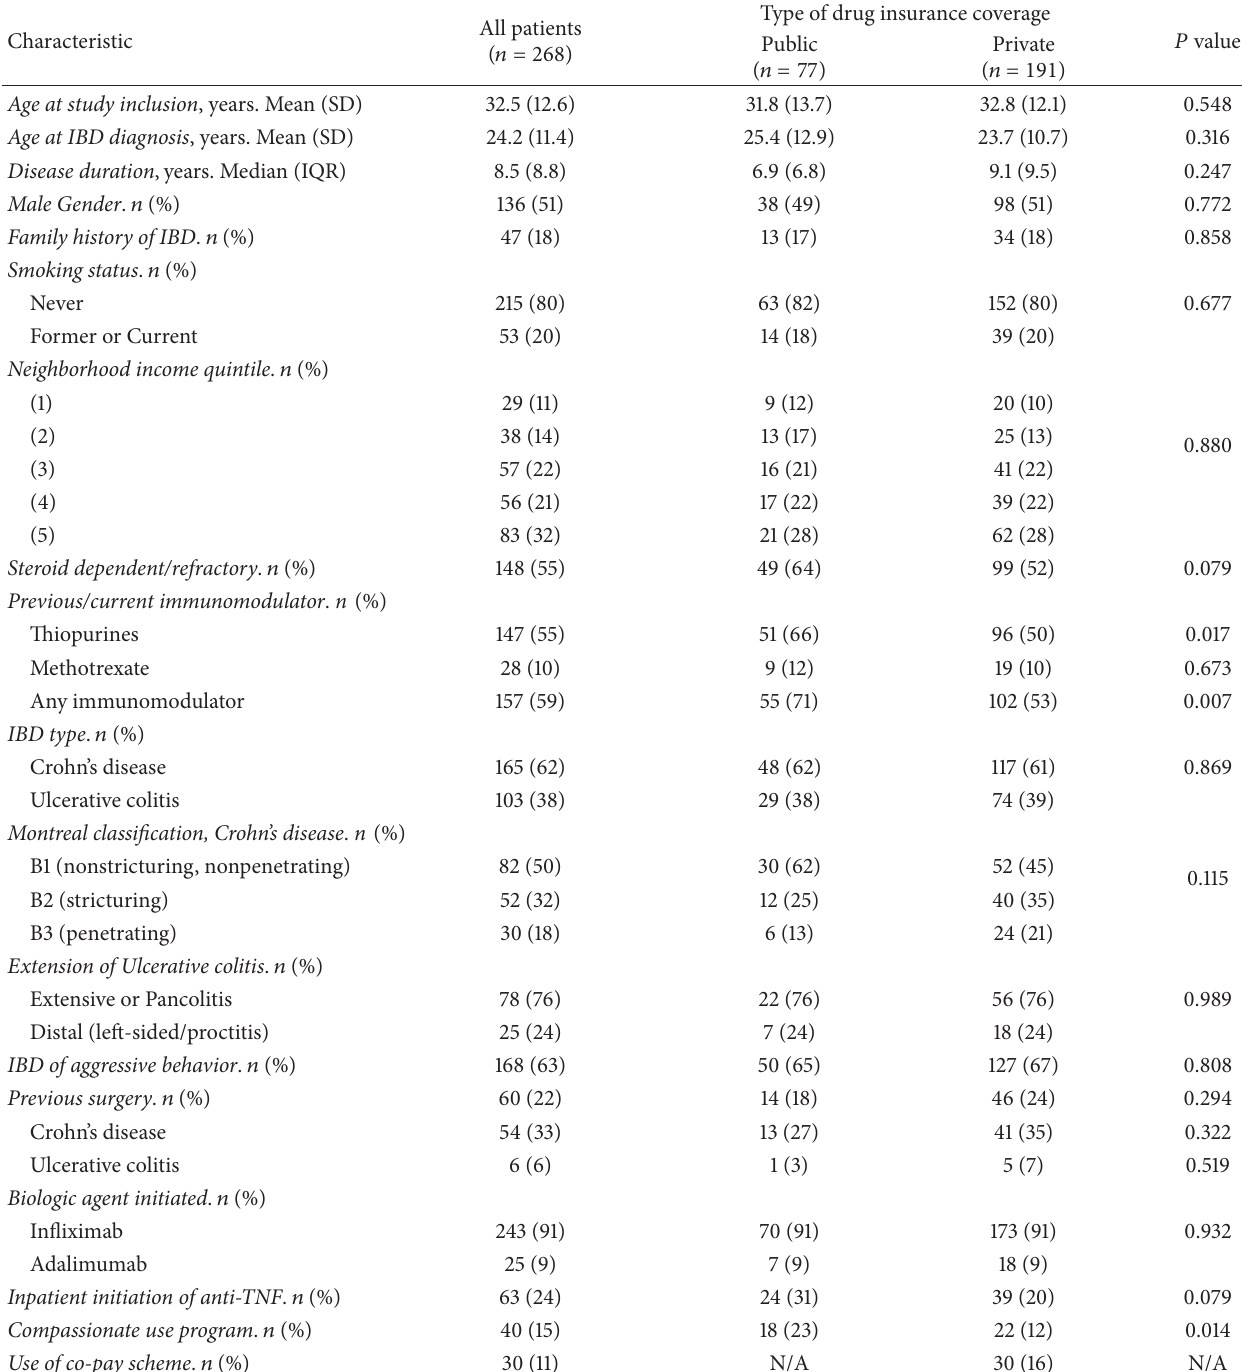
Table 2: Demographic and clinical